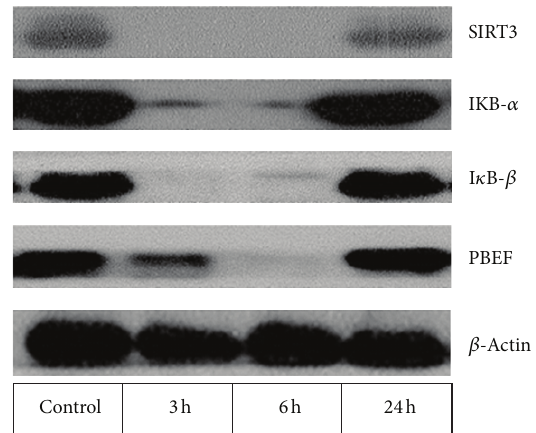
Figure 3: Protein expression of SIRT3, IKB- 𝛼 , I 𝜅 B- 𝛽 , PBEF, and 𝛽 - actin in PBMC before and 3h, 6 h, and 24 h after LPS administration in a healthy subject. A transient decrease in SIRT3, IKB- 𝛼 , I 𝜅 B- 𝛽 , and PBEF proteins was